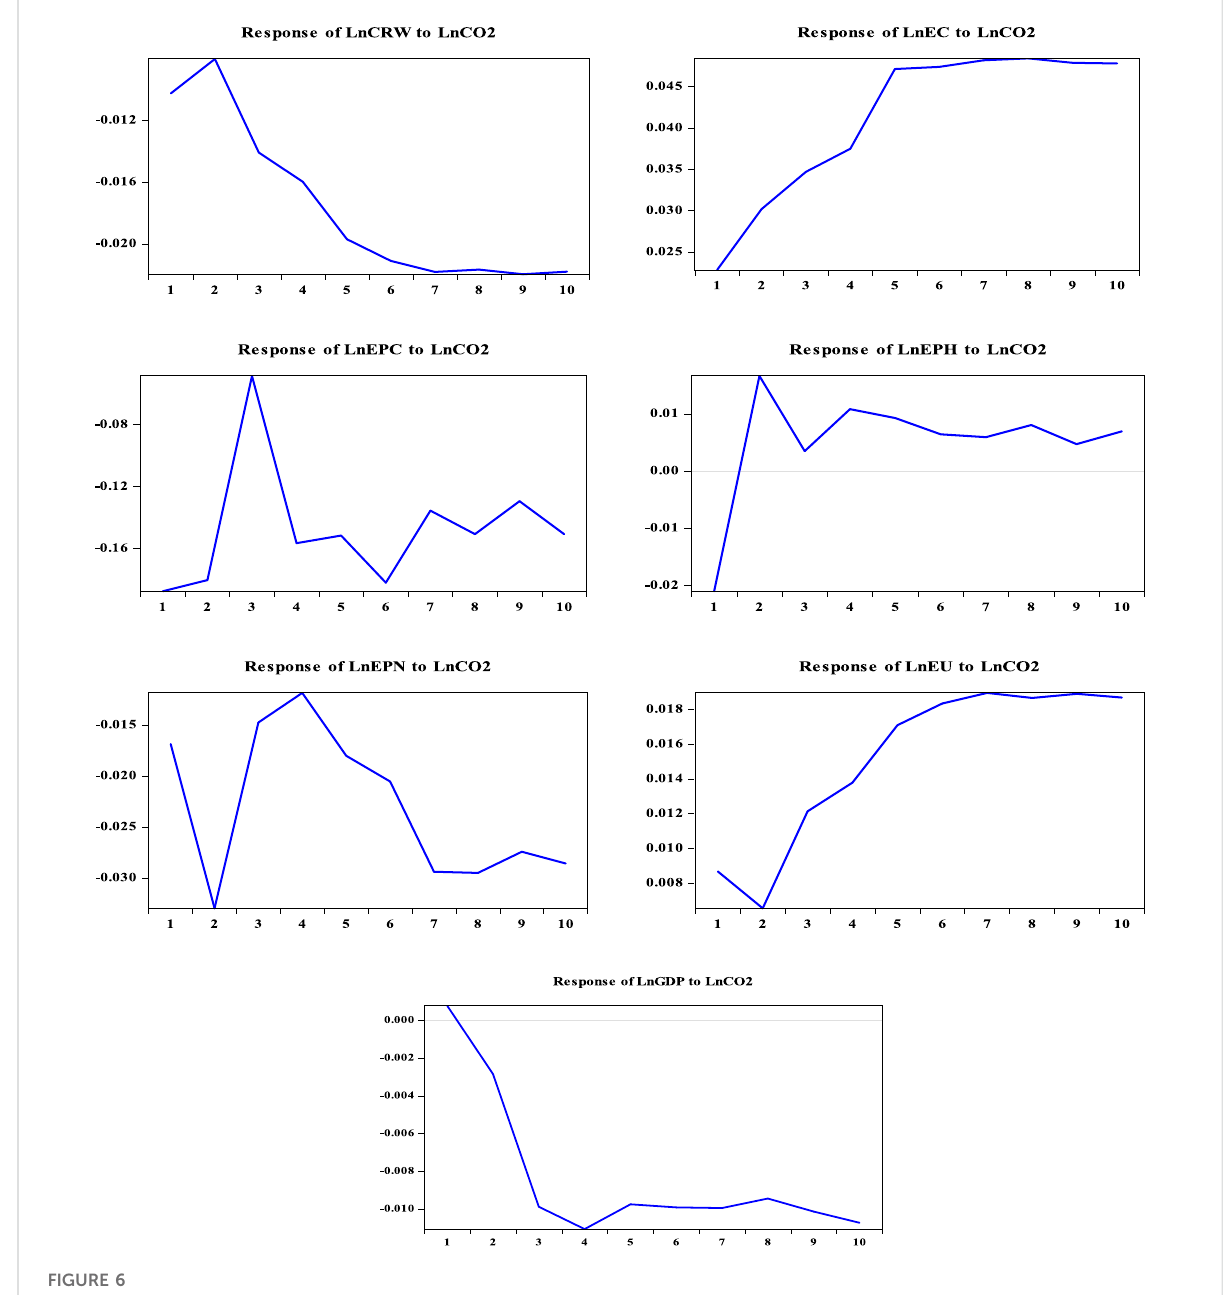
FIGURE 6 Impulse response of other variables to CO 2